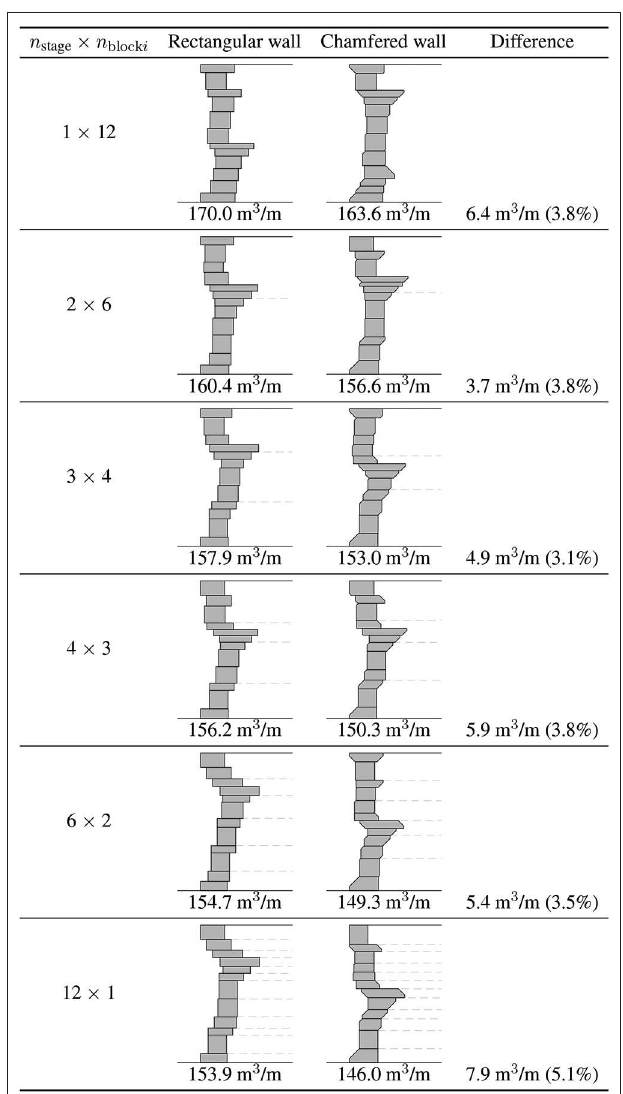
FIGURE 6 | Optimal designs for the rectangular and chamfered block wall, including the resulting wall volume. The gradual backfill stages are indicated with dashed lines.